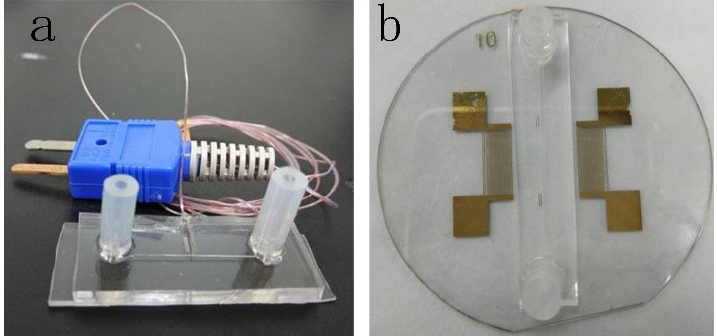
Figure 1. The microfluidic devices. ( a ) Microfluidic device for calibrating the relationship between the fluorescent signal intensity ratios and the temperature. ( b ) Acoustofluidic device for heat RhB solution.